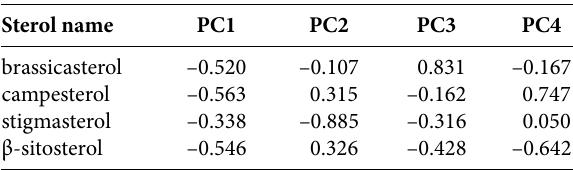
Table 7. Loadings values of the variables associated with principal components calculated using sterol composition data